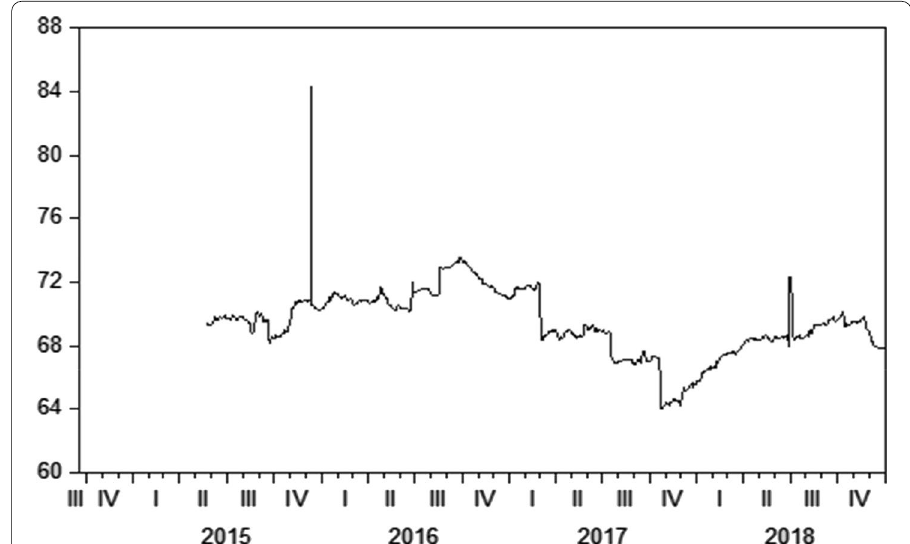
Fig. 6 Average volatility spillover (250 days rolling window)—Bitcoin markets and foreign exchange pairs denominated in major trading currencies. The Y-axis depicts the volatility spillover values and the X-axis depicts the time